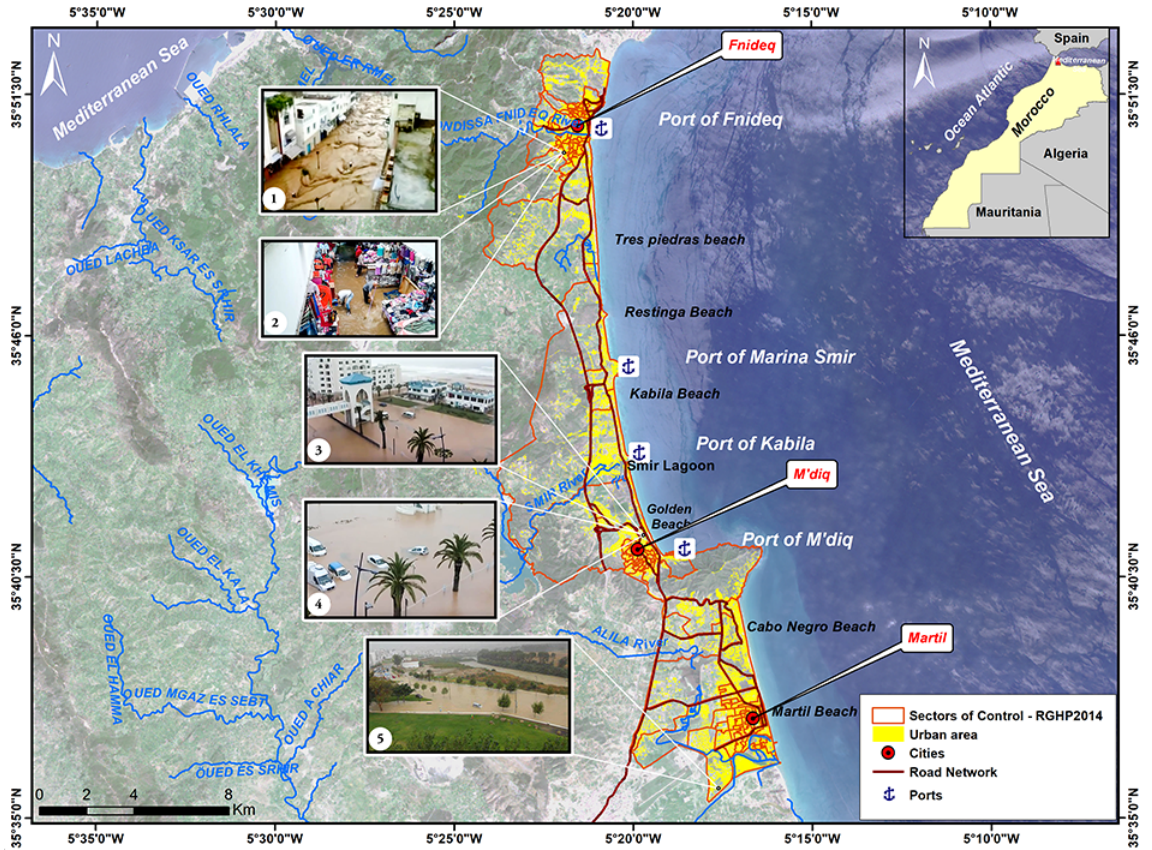
Figure 1. Location of the three studied municipalities: Fnideq, M’diq, and Martil, in northern Morocco, and examples of the flooding (1: photo of Fnideq centre on 28 September 2008; 2: photo of Almassira commercial centre Fnideqin on 27 September 2014; 3 and 4: photos of M’diq on 6 March 2010; 5: photo of Martil River on 2 March 2018). © Copernicus data